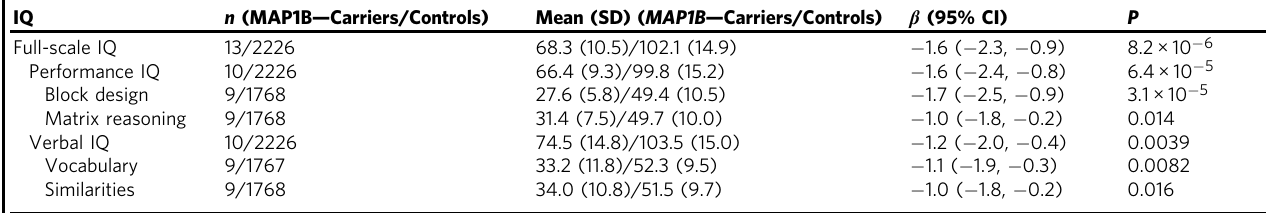
Table 1 IQ scores for MAP1B LoF carriers compared with controls